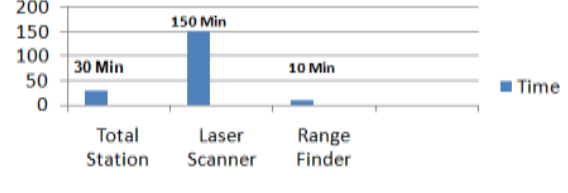
Figure 9. Equipment comparison based on the time of measurement